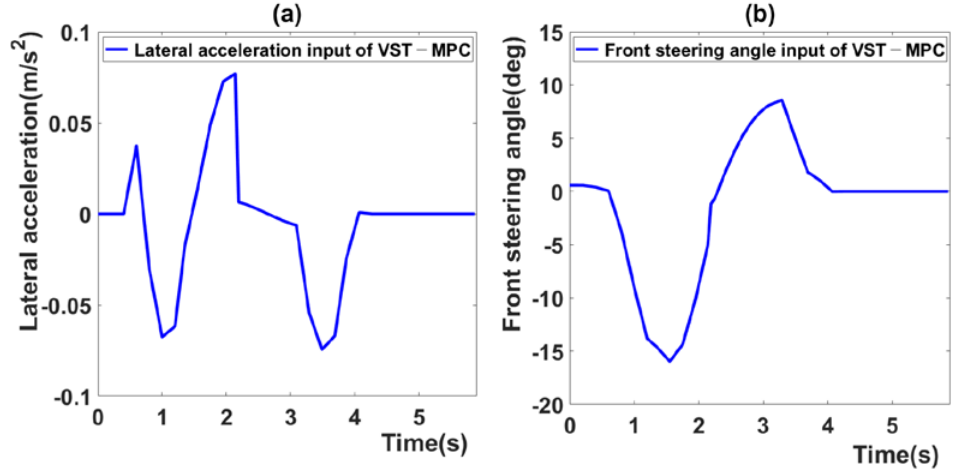
Figure 10. ( a ) Lateral acceleration input of VST-MPC in scenario 2, ( b ) steering angle input of VST-MPC in scenario 2.